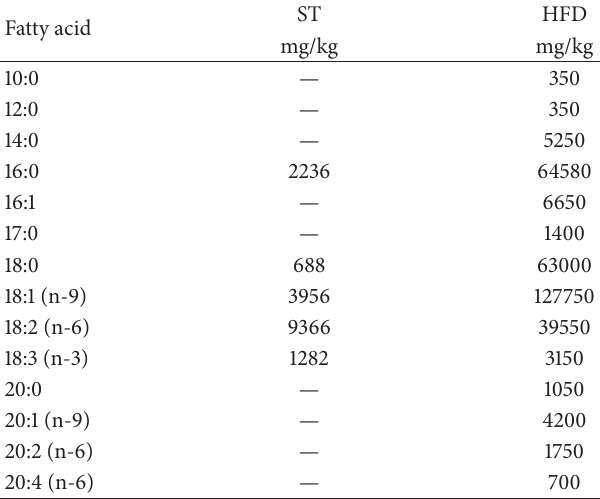
Table 1: Fatty acid composition of standard (low fat) diet and high fat